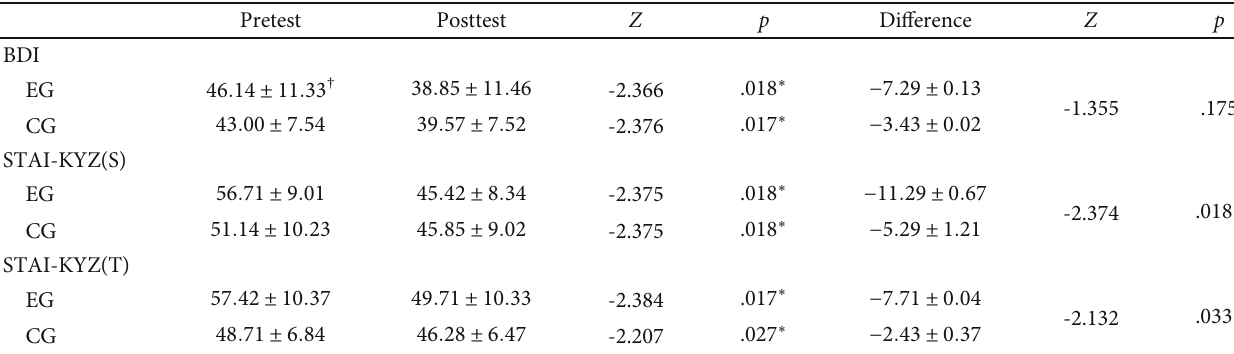
Table 6: Changes of psychological function before and after intervention ( N = 14 ).